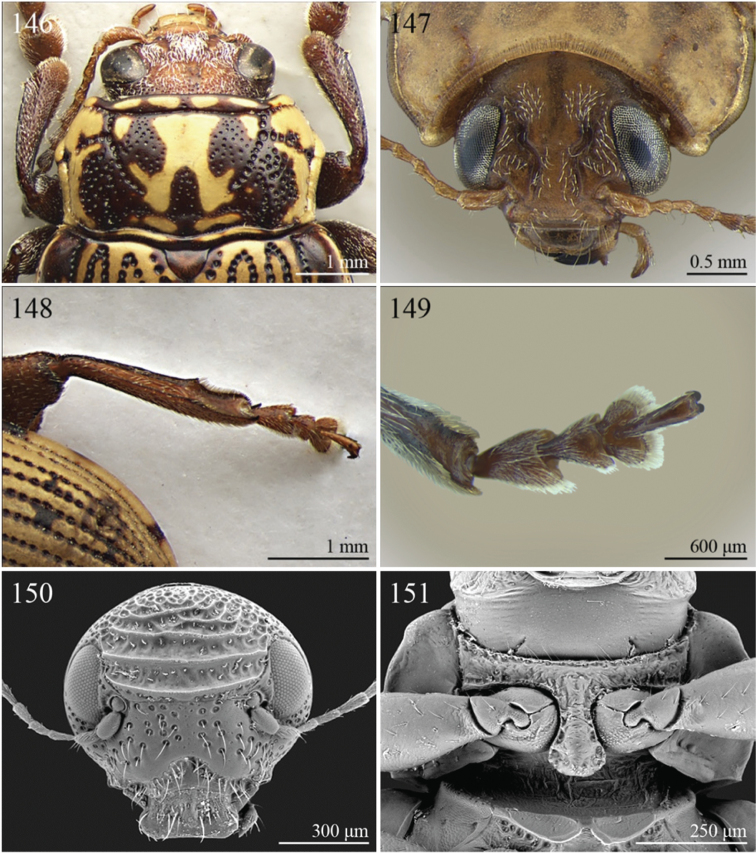
Morphological characters. 146
Blepharida intermedia Jacoby, head and pronotum in dorsal view 147
Blepharida reticulata (Baly), head in frontal view 148
Blepharida ugandae Bryant, hind leg 149
Blepharida geminata Bryant, metatarsus 150
Carcharodis malvernensis Bechyné, head in frontal view 151
Celisaltica ruwenzorica Biondi, prosternum.